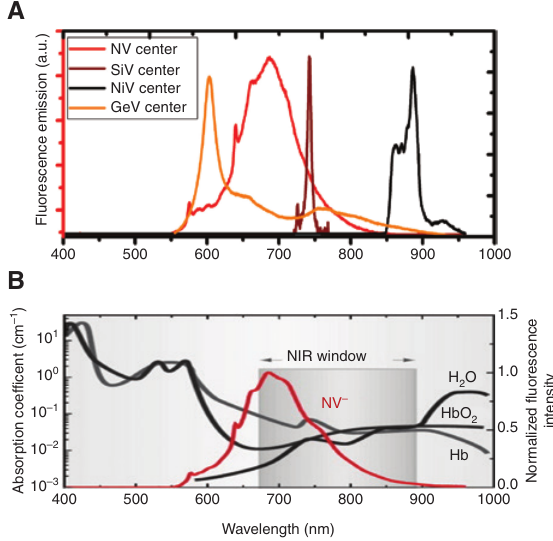
Figure 19: New fluorescent nanodiamonds in the biological transparency window. (A) Superimposed photoluminescence spectra of color centers in nanodiamonds (FNDs), namely, germanium-vacancy (GeV), nitrogen- vacancy (NV), silicon-vacancy (SiV), and nickel-vacancy (NiV). (B) The fluorescence spectra of all diamond color centers in (a) fit within the biological transparency window. The black, dark gray, and light gray curves are the absorption spectra of H O, oxygen-bound 2 hemoglobin (HbO ), and hemoglobin (Hb), respectively. Adapted 2 from